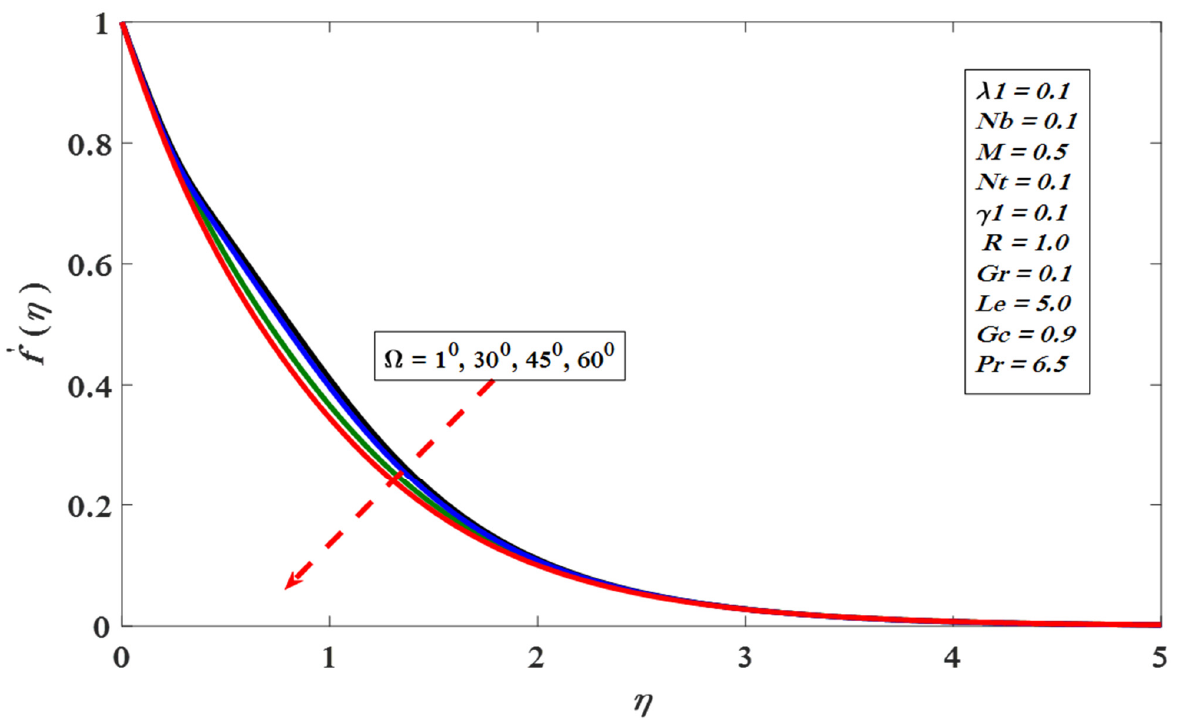
Ω Figure 5. Velocity profile versus Ω Ω